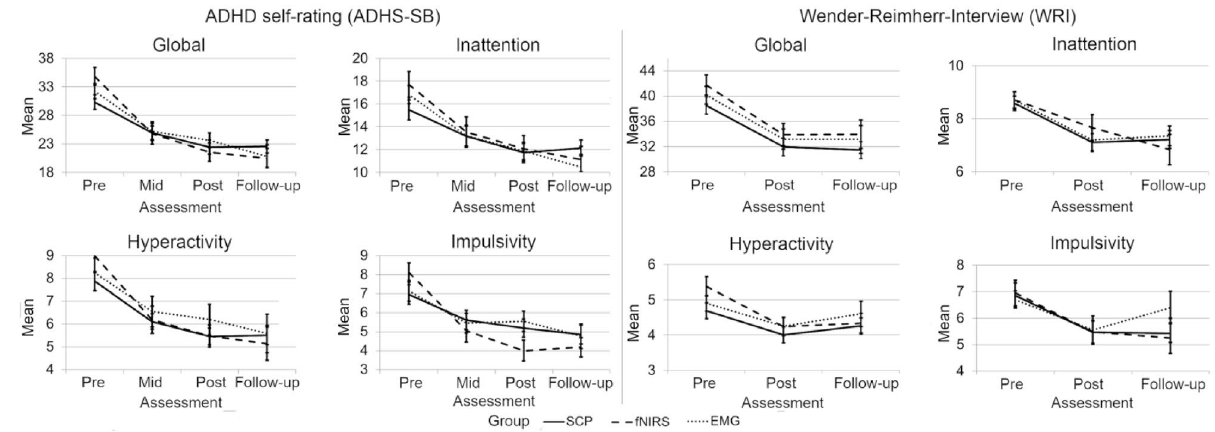
Figure 6. Clinical trajectories for primary outcome assessments ADHS-SB and WRI on the global scale as well as on inattention-, hyperactivity- and impulsivity